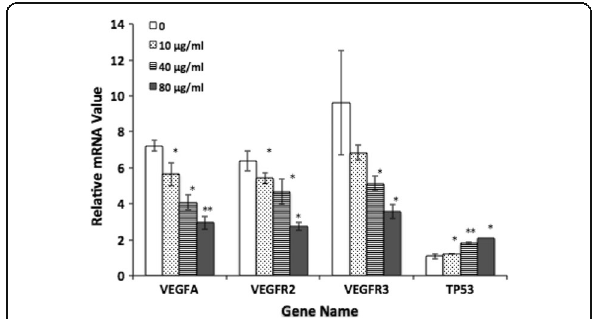
Fig. 9 Gene expression comparison after exposure to various concentrations (10 – 80 μ g/ml) of oridonin. The asterisks indicate statistically significant differences from the control group (* P < 0.05; ** P <